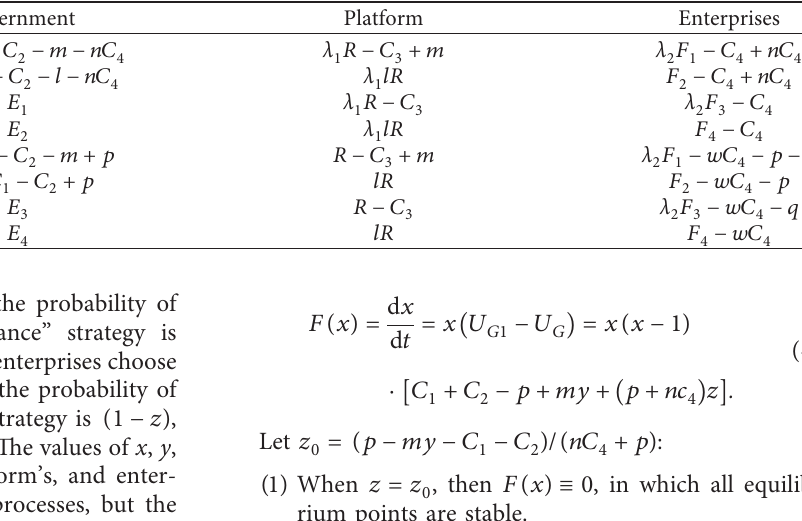
Table 2: The benefits of the game’s three